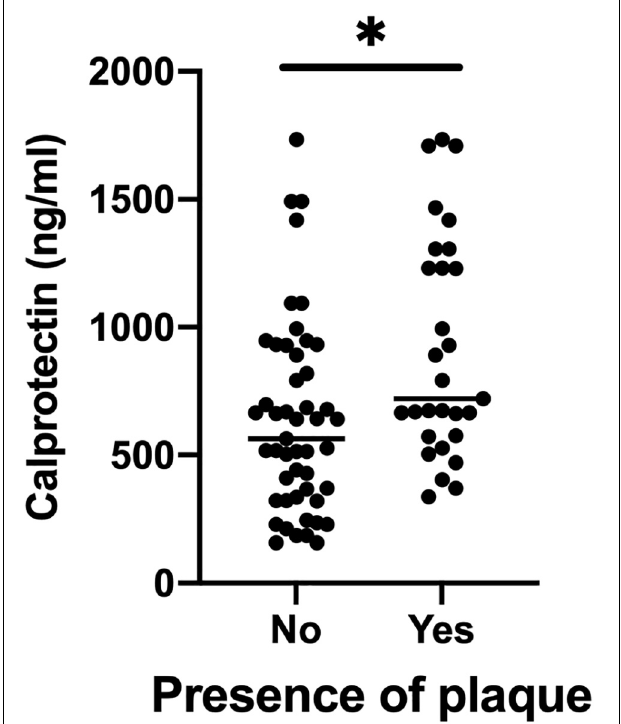
Supplementary Table 2 . Two (Ln-calprotectin and PsA disease